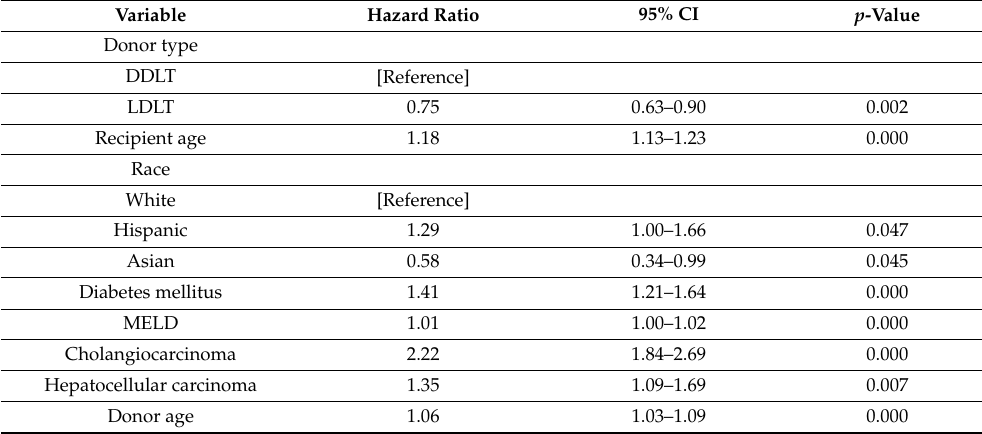
Table 3. Stepwise multivariate Cox proportional hazard analyses of predictors of post-transplant patient survival.